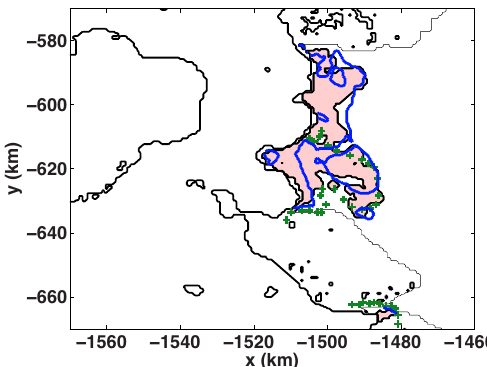
Figure 8. A detailed comparison of modeled grounding lines, the grounding line implied by the data used in the modeling study, and directly observed grounding-line position. The red shaded area rep- resents the portion of the domain which is ungrounded in 2011, in- ferred from floatation with the 2011 surface DEM and BEDMAP2, and assuming ice and ocean densities of 918 and 1028kgm − 3 , re- spectively. The blue contour is the modeled 2011 grounding line, and green hatches give the 2011 grounding line position from Rig- not et al. (2014). The thin black contour is the computational bound- ary, and the thick black contour the 1996 grounding line. Note that the Rignot et al. (2014) data do not extend to Pope